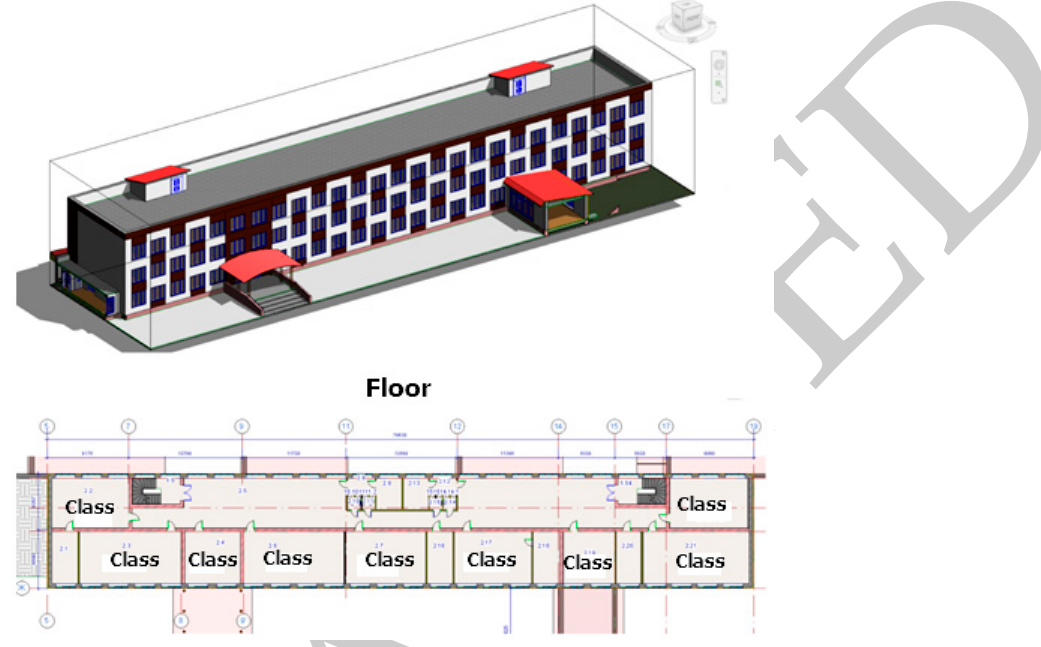
Figure 2. Analyzed school building. Arrangement of rooms on the level.